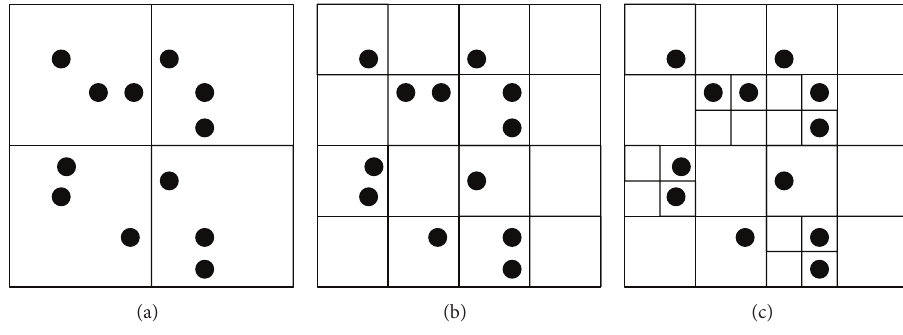
Figure 3: The quad tree partition: (a) 𝐶 = 3 , (b) 𝐶 = 2 , and (c) 𝐶 = 1 .